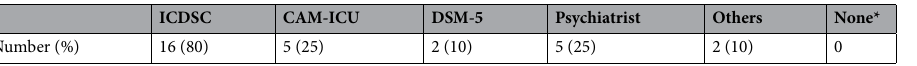
Table 1. Number of institutions introducing each delirium assessment tool. ICDSC Intensive Care Delirium Screening Checklist, CAM-ICU Confusion Assessment Method for the Intensive Care Unit, DSM-5 Diagnostic and Statistical Manual of Mental Disorders, Fifth Edition. Data are n (%). The percentages add up to over 100% because multiple selections were possible. *Institutions that had never assessed